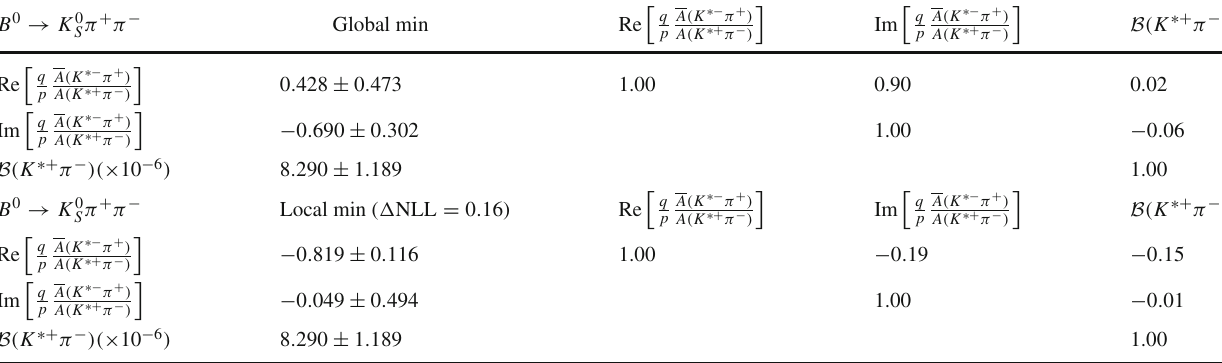
Table 2 Central values and total (statistical and systematic) correlation matrix for the global (top) and local (bottom, (cid:9) NLL = 0 . 16) minimum π + π − solutions for the BaBar B 0 → K 0 S